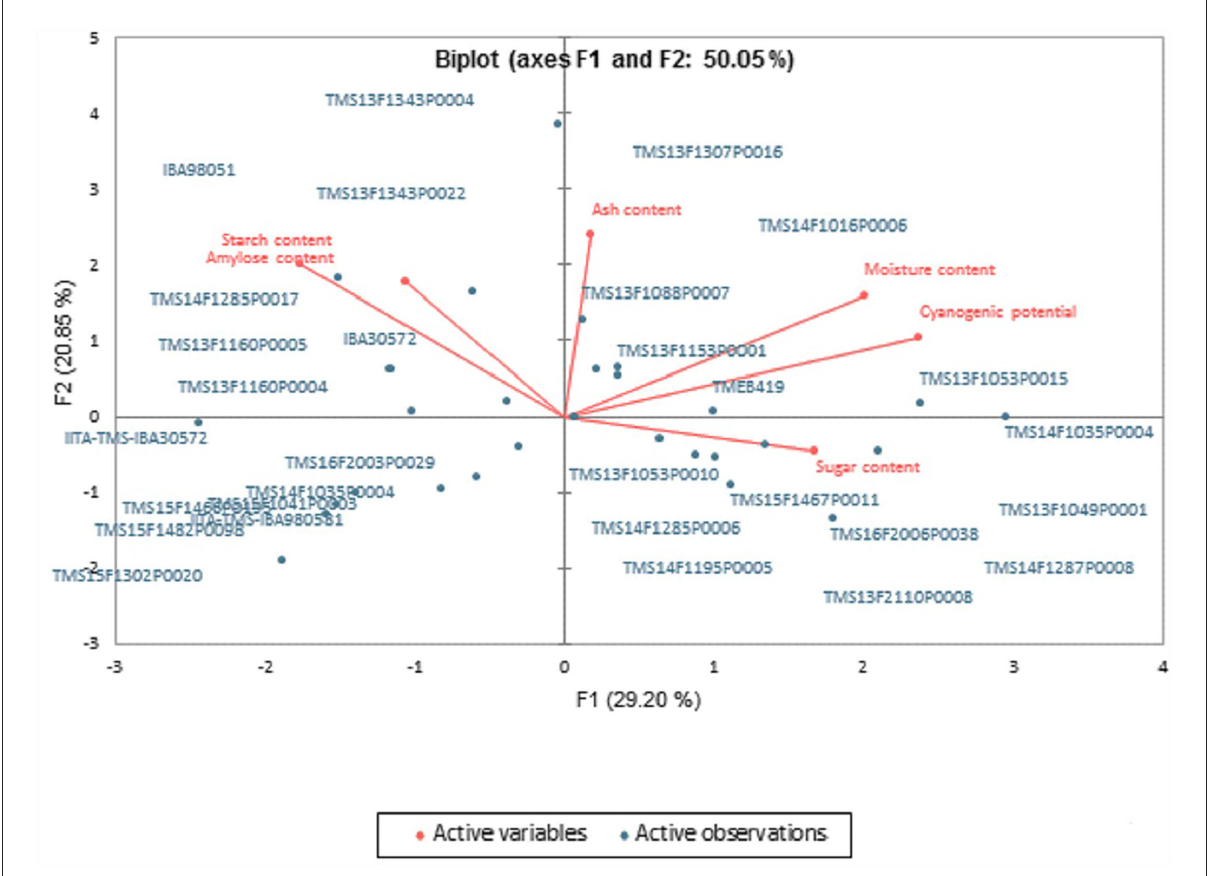
FIGURE3 The principal component analysis biplot of the chemical composition of gari